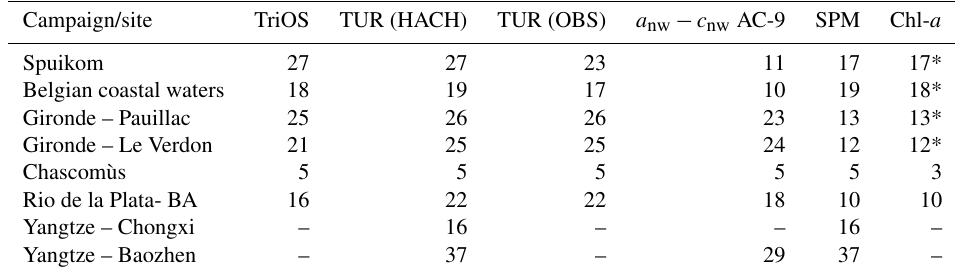
Table 2. Number of observations for each sampling site.